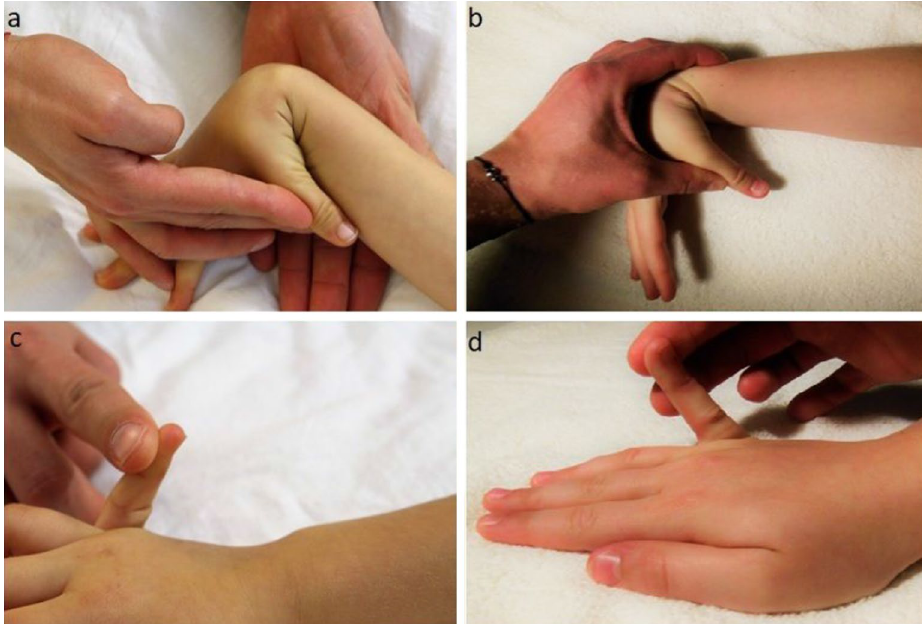
Figure 3. Examples of joint hypermobility: (a,b) excessive and normal passive apposition of thumb to forearm, (c,d) excessive and normal passive hyperextension of 5th metacarpophalangeal